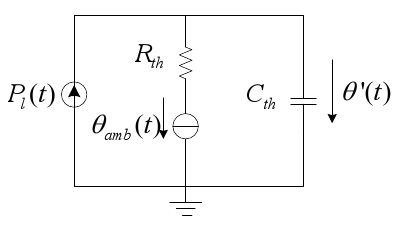
Figure 6. A generic thermal network model of the stator